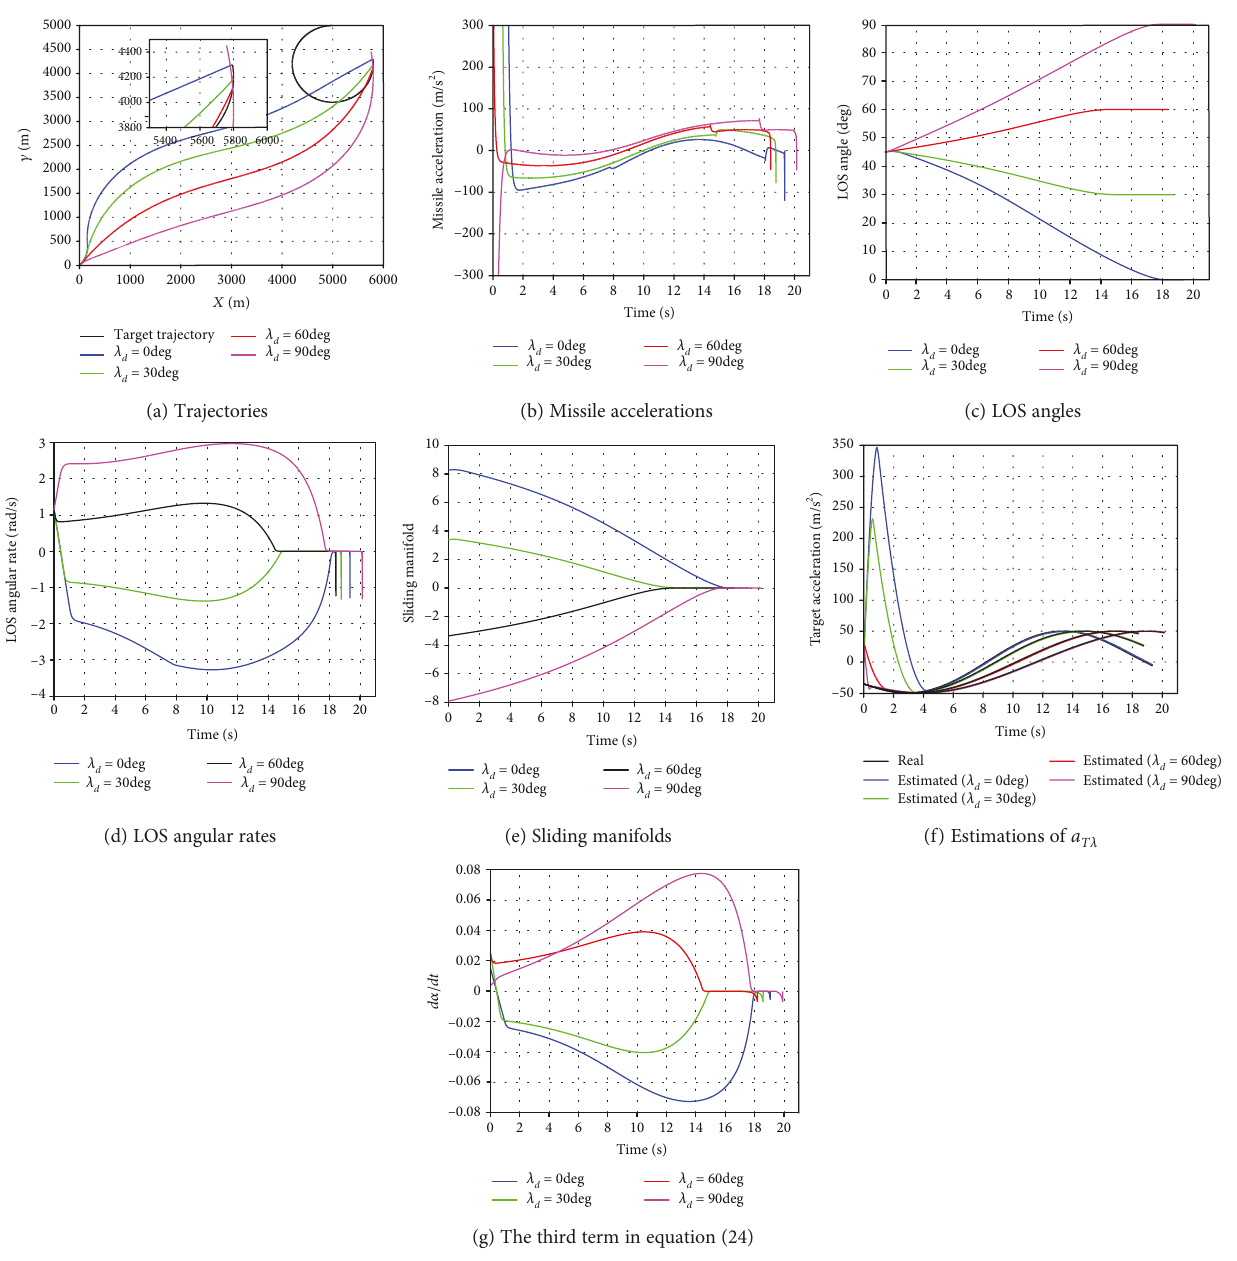
Estimated ( 휆 d = 60deg)